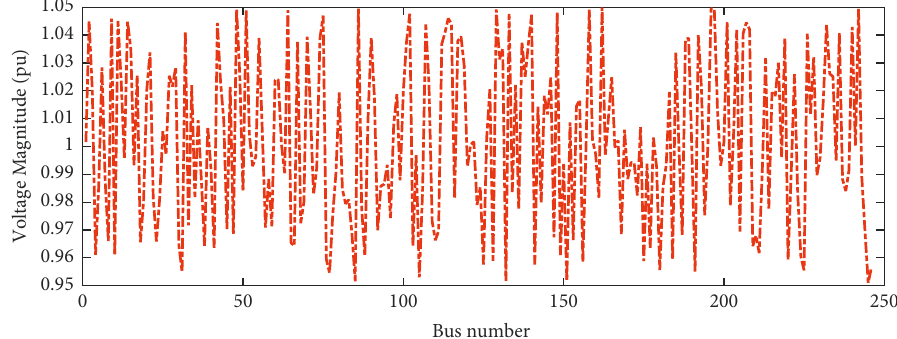
Figure 10: Voltage magnitude after STATCOM is